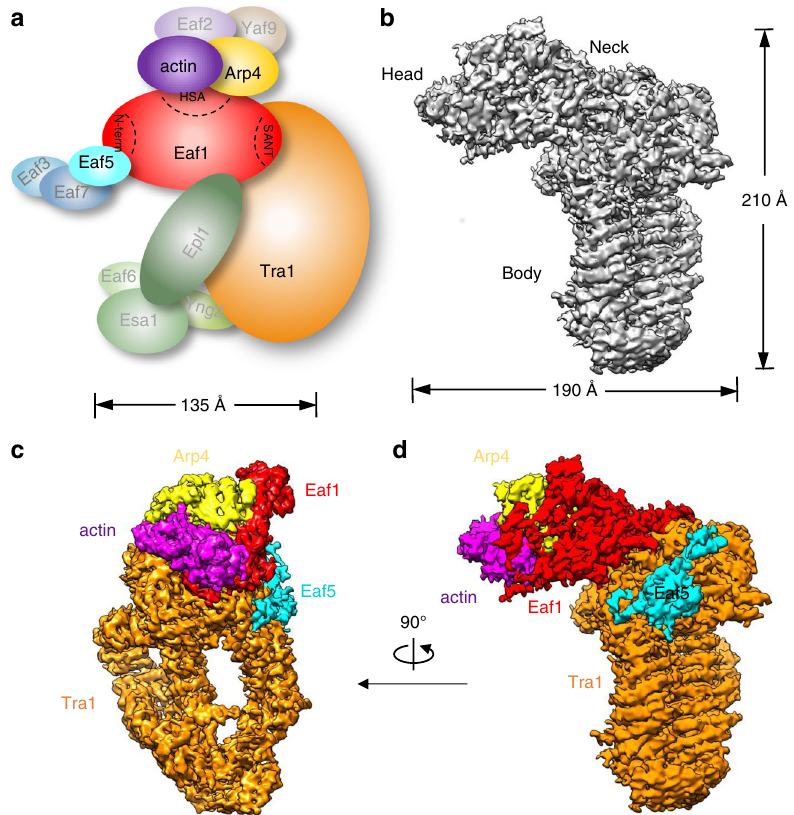
Fig. 1 Cryo-EM structure of the NuA4 TEEAA sub-complex. a Schematic view of subunit and modular organization of the NuA4 complex from S . cerevisiae . The TEEAA subunits are highlighted. b The front view of the cryo-EM density map of the NuA4 TEEAA assembly at 4.7 Å. c , d Two views of the NuA4 TEEAA assembly with the density map color-coded by subunit assignment, the same as panel a . Arp4 is in yellow, actin in purple, Eaf5 in cyan, Tra1 in orange and Eaf1 in